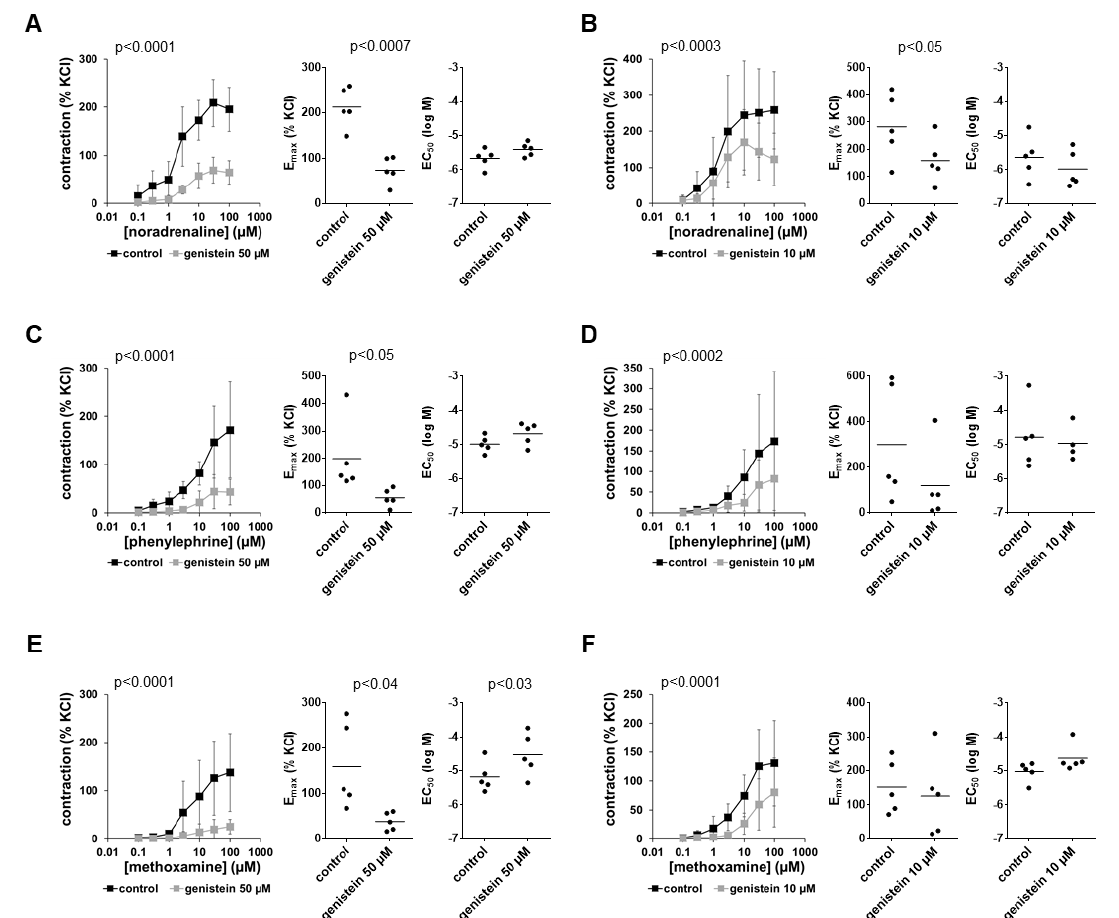
Figure 1. Effects of genistein on α 1 -adrenergic contractions of human prostate tissues. Contractions were induced by the α 1 -adrenergic agonists noradrenaline ( A , B ), phenylephrine ( C , D ) and methoxamine ( E , F ) in the presence of 50 µM genistein ( A , C , E ), 10 µM genistein ( B , D , F ) and corresponding amounts of solvent (DMSO) for the controls added 30 min before the construction of concentration–response curves. Data from experiments with tissues from n = 5 patients are shown in each diagram. In each experiment, tissue from one patient was allocated to the control and genistein groups. Data are means ± SDs in concentration–response curves ( p -values for whole groups from two-way ANOVA), and E max and EC 50 values are from all single experiments (calculated by curve fitting) in scatter plots ( p -values from two-tailed t